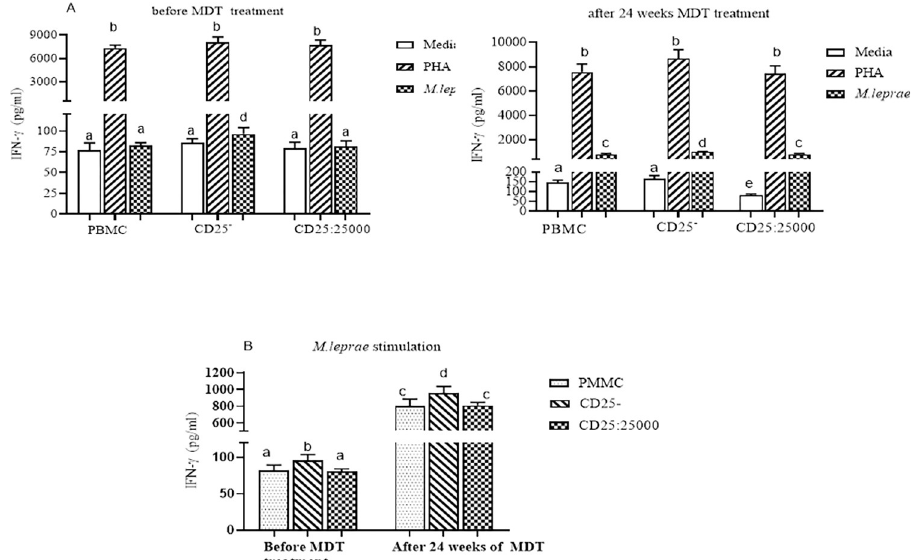
Fig 2. The effect of depletion of CD25 + cells on IFN γ secretion by PBMC from LL participants (n = 30): (Fig 2A) IFN γ response to PHA and M . leprae WCS stimulation before and after 24 weeks of MDT: (Fig 2B) IFN γ response to M . leprae WCS stimulation in control PBMC, CD25+ depleted PBMC and autologous CD25 + cells re-added to CD25 + depleted cells from individuals with uncomplicated LL before and after 24 weeks of MDT. Each bar graphs shows mean ± 95% confidence interval (CI). Any pair of different letters shows that the mean of IFN γ production of the two groups are statistically significantly different at p = 0.05 and any pair of similar letters indicates that the mean of IFN γ production the two groups are not statistically significantly different at P � 0.05 and 95% CI. CI is calculated for mean difference. Media indicate AIM-V medium only and it was used in the assay as a negative control and PHA used as a mitogen (positive